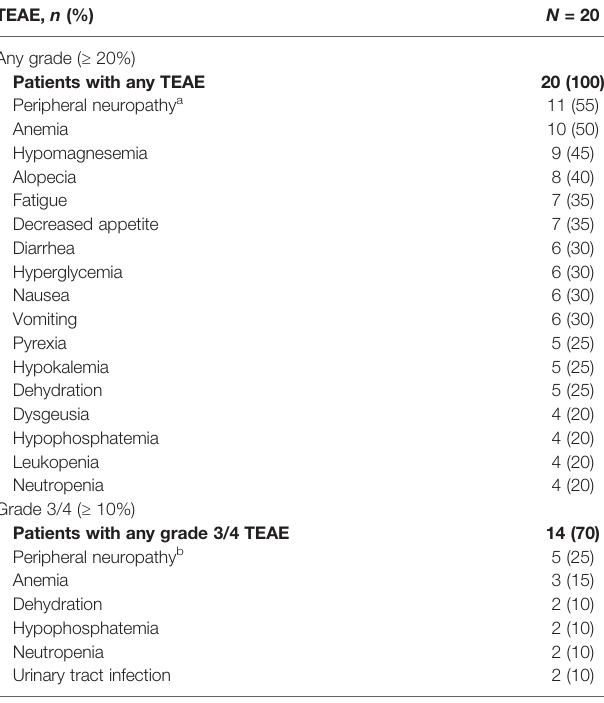
TABLE 3 | Incidence of the most common any-grade and grade 3/4 TEAEs (all doses): safety population. TEAE, n